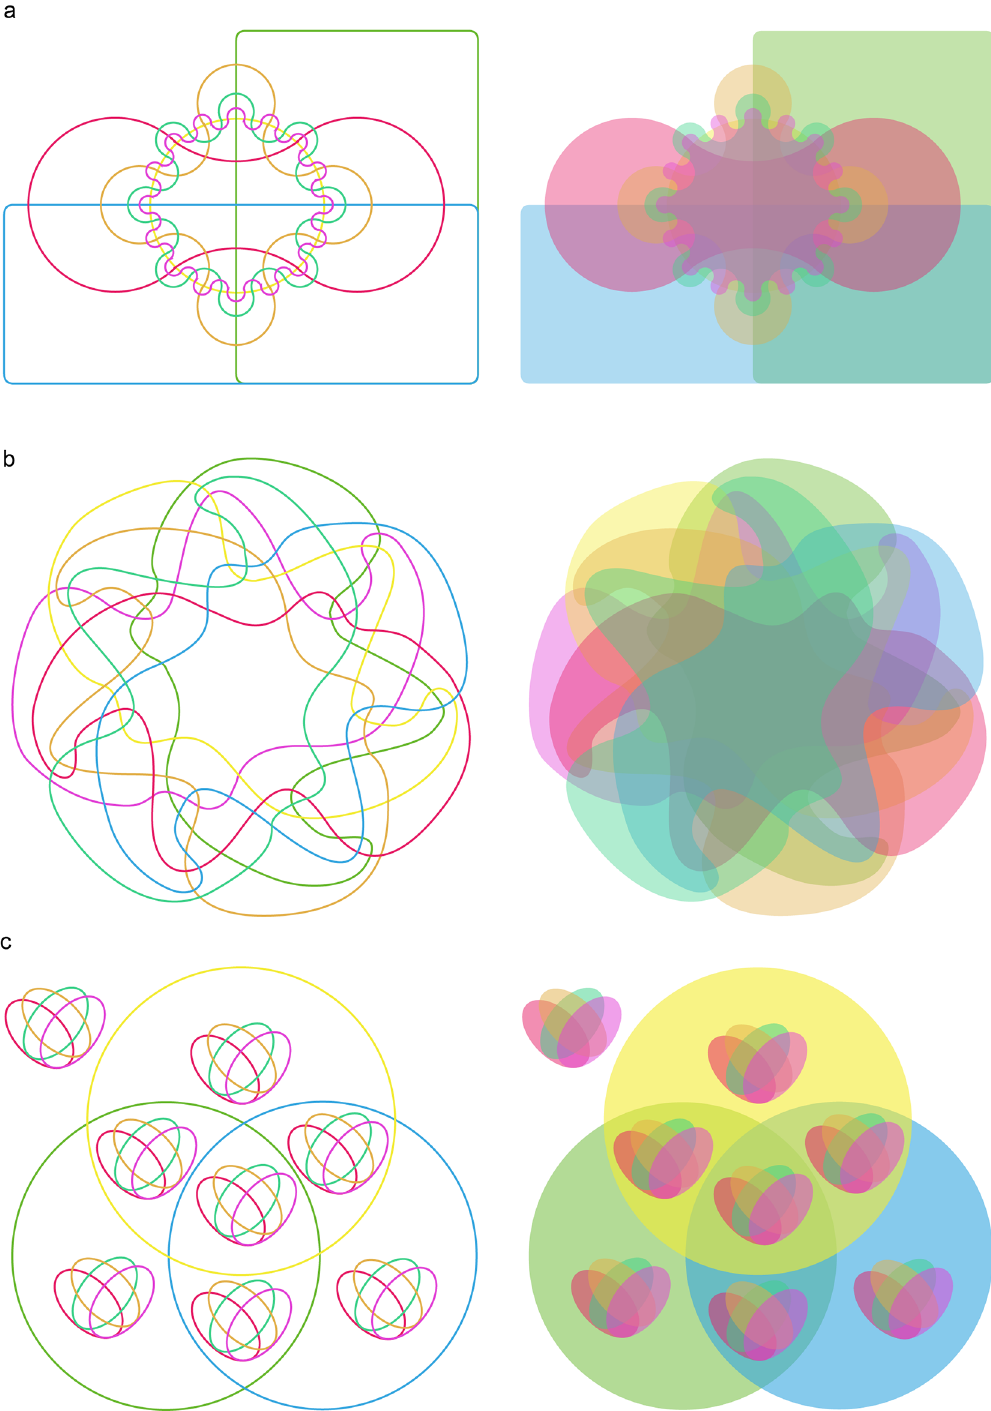
Fig 1. Venn diagrams for seven sets. (a) Edward ’ s Venn diagram constructed with cogwheels, which become smaller with increasing numbers of sets. With seven sets, this made it hard to fill intersections with a number. (b) Venn diagram constructed with irregular curves. Some intersections are unclear. (c) Nested Venn diagram places its intersections more evenly and regularly, which facilitates accurate